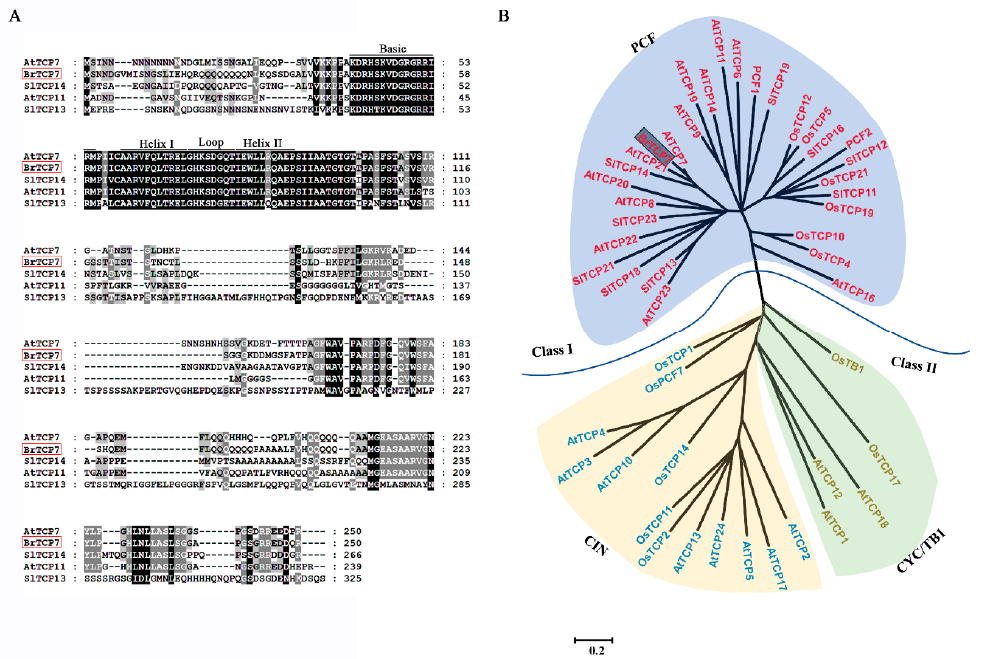
Figure 2. Multiple sequence alignment and phylogenetic analysis of BrTCP7. ( A ) Multiple alignment of BrTCP7withotherTCPmembers. Thefollowingproteinswereusedforanalysis: AtTCP7(NP_197719.1), AtTCP11 (NP_196450.1), SlTCP13 (NP_001233966.1), and SlTCP14 (NP_001293140.1). Identical and similar amino acids are shaded in black and grey, respectively. Single underlining indicates the conserved non-canonical basic helix–loop–helix structure. ( B ) Phylogenetic analysis of TCPs.